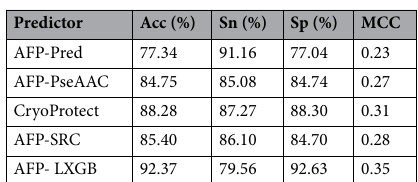
Table 7. Comparison with existing predictors on the testing set.